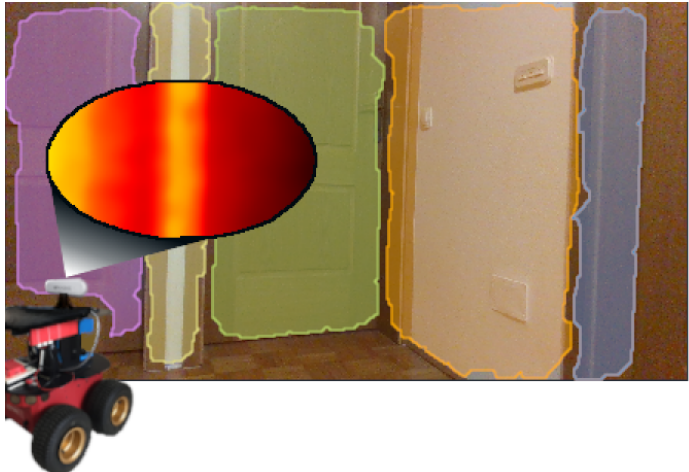
Figure 1. Example of 3D sensing of an indoor environment in the form of flat surfaces, where color represents clusters. Depth image points whose color encodes depth distance are segmented using the EPCC